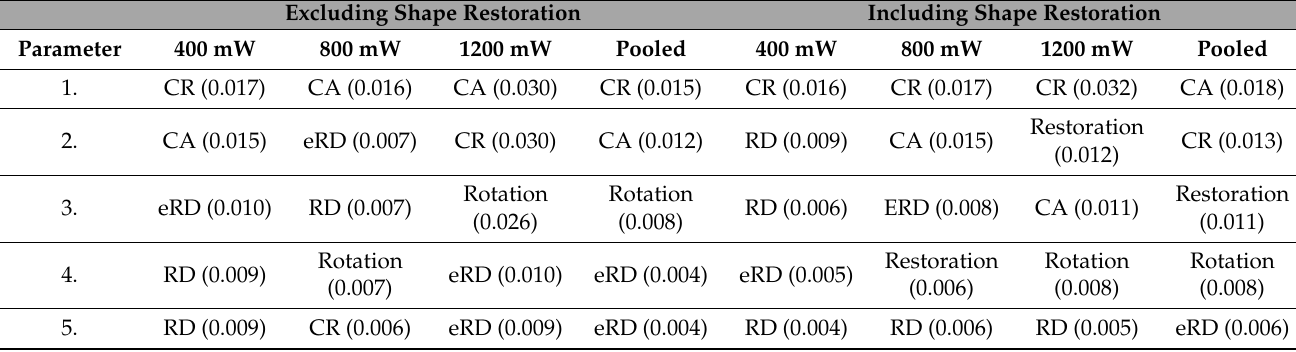
Table A2. The first 5 most important parameters and their importance values of all experiments. CR: cell radius, CA: cell area, RD: fitting parameters associated with the relative cell deformation, eRD: fitting parameters associated with the elliptic cell deformation, Rotation: cell rotation during relaxation phase, Restoration: cell restoration parameters. Excluding Shape